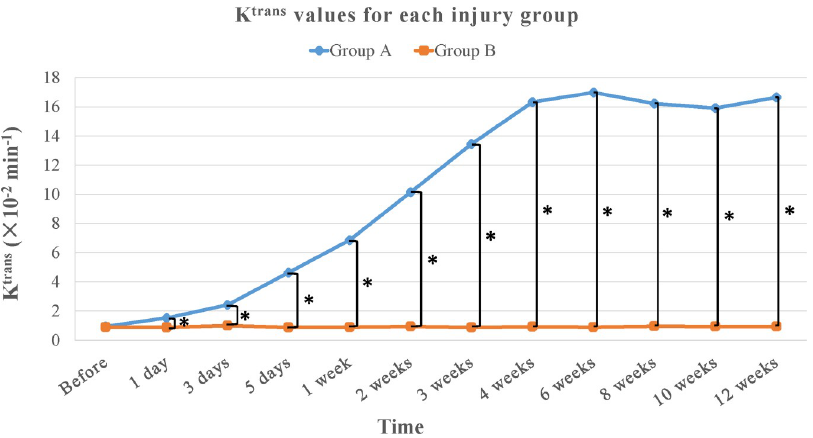
W = week. P -value represents the comparison results between group A and B by the one-way analysis of variance analyzation. � P values indicate statistical